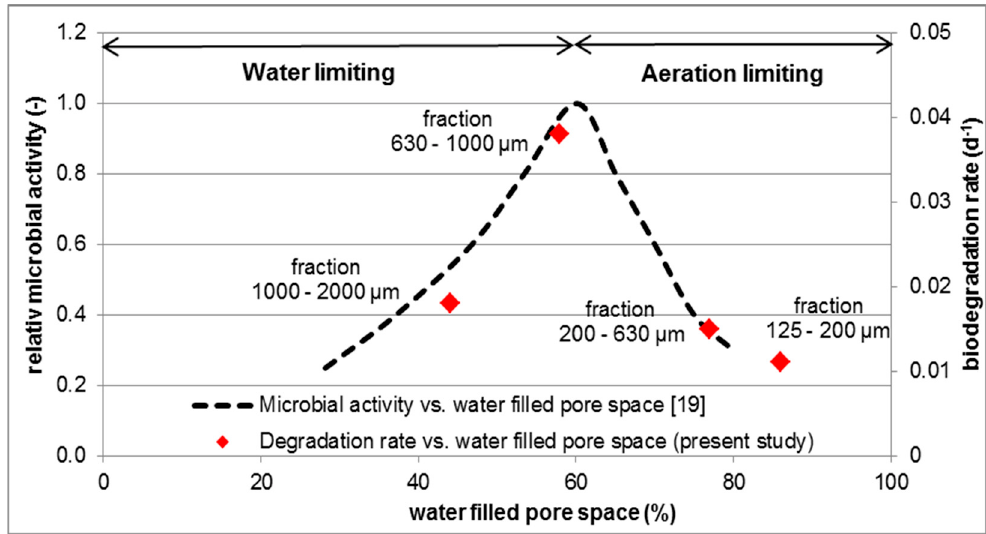
Figure 4. Correlation between experimental biodegradation rates and WFPS in the used grain size fractions.